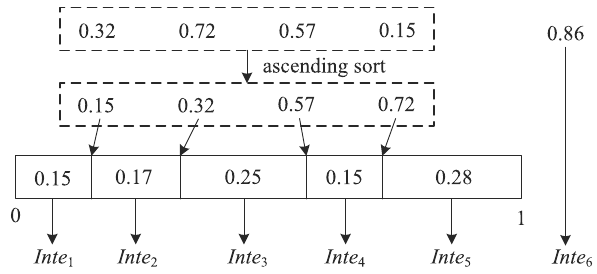
Fig. 4 An example of integration factors encoding